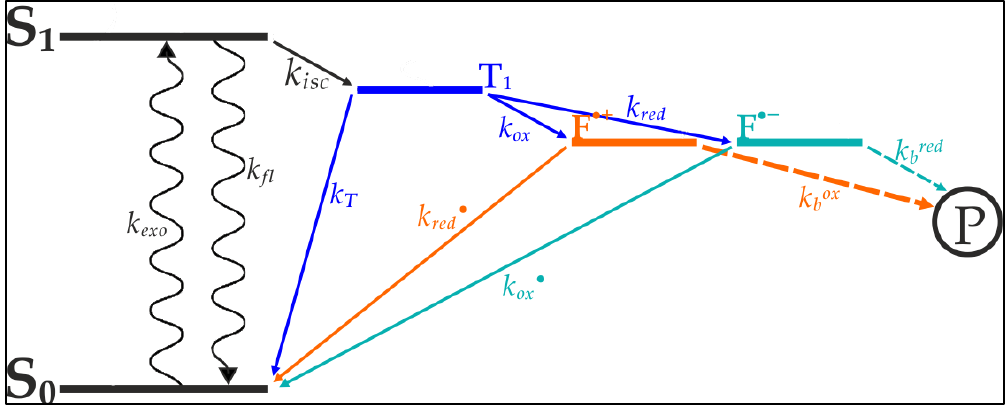
Figure 1. Schematic model of photoinduced electron excitation of organic fluorophores such as cyanine dyes. From its ground state (S 0 ) the electron is excited to the first singlet state (S 1 ). The sporadically forming triplet state (T 1 ) is the point of origin for several transitions resulting in the formation of the photobleaching product (P). Methylviologen and ascorbic acid both rapidly deplete the T 1 , forming a radical cation (F • + through methylviologen) or a radical anion (F •− through ascorbic acid). These radical ions rapidly recover through reduction (ascorbic acid) or oxidation (methylviologen). The combination of an oxidizing agent and a reducing agent (ROXS) therefore minimizes photoinduced formation of P. Model, according to Vogelsang et al. [20].